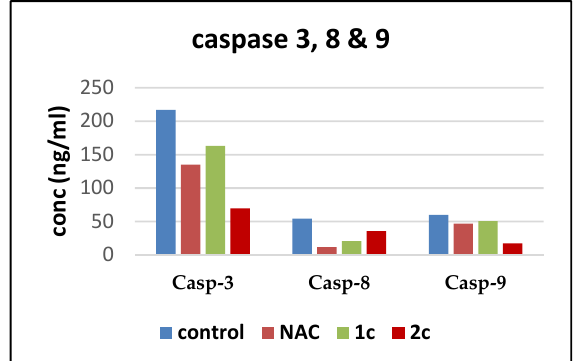
Figure 7. Effects of compounds 1c, 2c, and NAC on Conc (ng/mL) of the active caspases-3, 8, and 9.